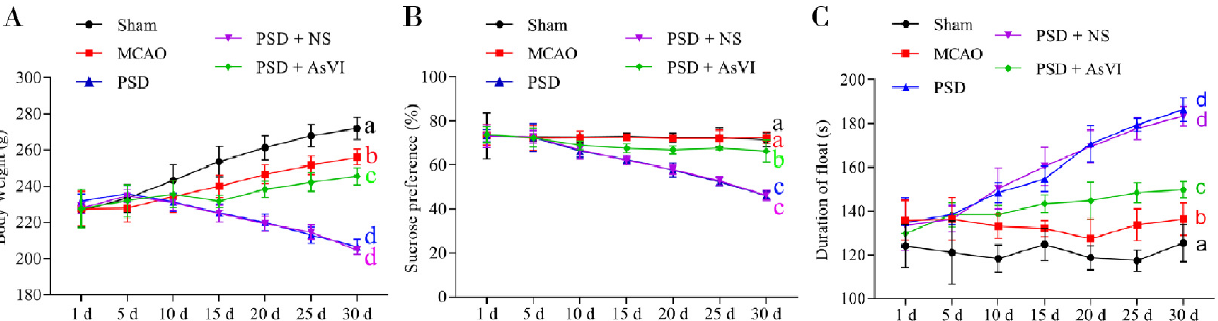
Figure 1. Time schedule of experimental procedures.